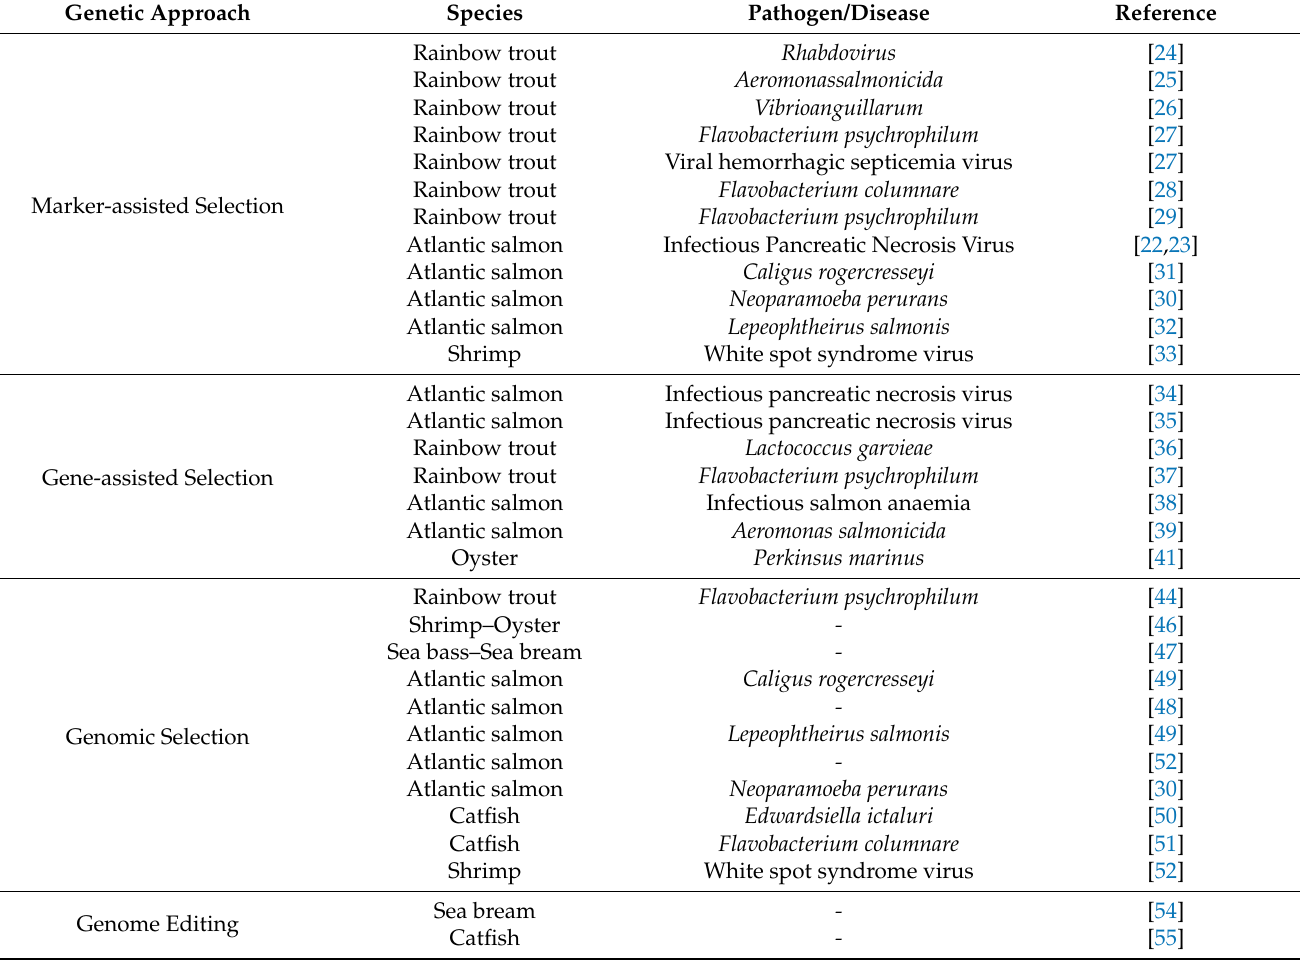
Table 1. Genetic selection in aquaculture